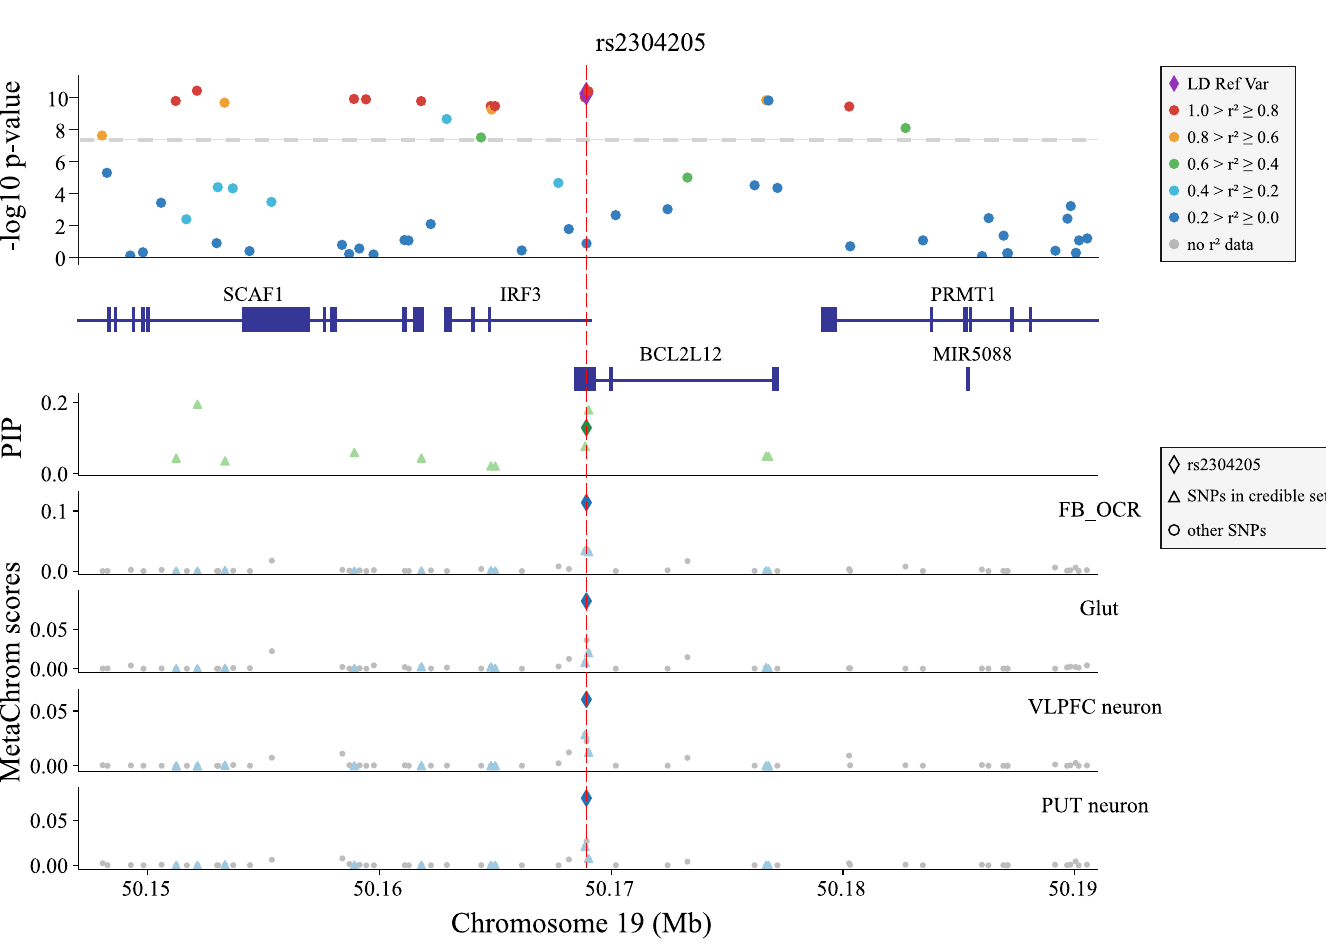
Fig 6. Likely causal variant rs2304205 and its MetaChrom functional annotations. The candidate SNP rs2304205 is chose as the reference variant for computing LD and it is highlighted by the red dash line in each panel. The upper panel shows significance of GWAS SNPs, LD between SNPs and genes in this region. The next panel shows credible set SNPs identified by fine-mapping (PIPs) in this region. The remaining panels show MetaChrom scores in four cell types, two in fetal stage (FB OCR and Glut) and two in adult stage (VLPEC neuron and PUT